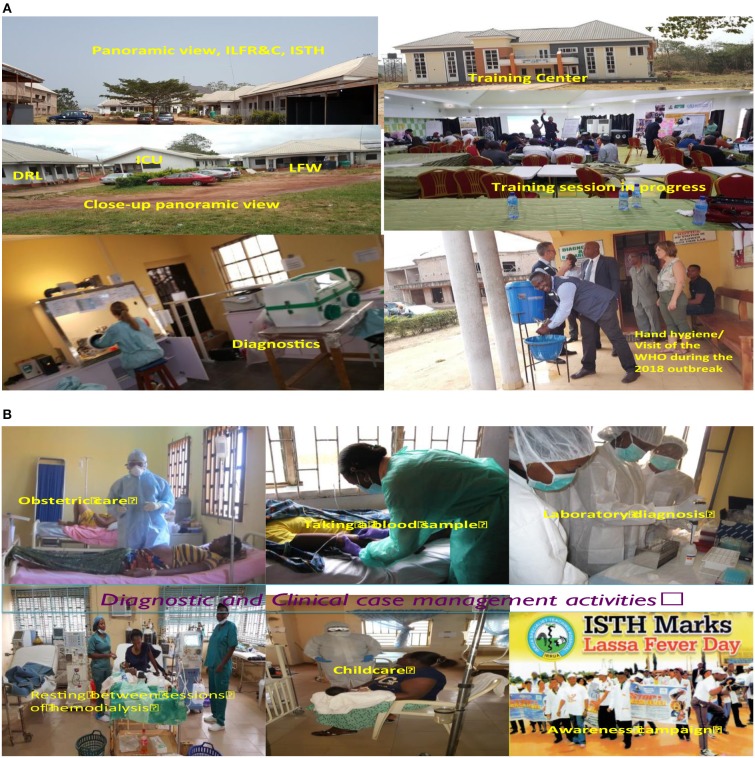
Panoramic view of the Institute of Lassa Fever Research and Control (ILFR&C), Irrua Specialist Teaching Hospital, Nigeria and its activities. (A) Panoramic view of the Institute, diagnostic activities, Training Center and training activities, and hand washing stand. (B) Panoramic view of clinical case management and diagnostic activities, and awareness campaign match on a national Lassa fever day.